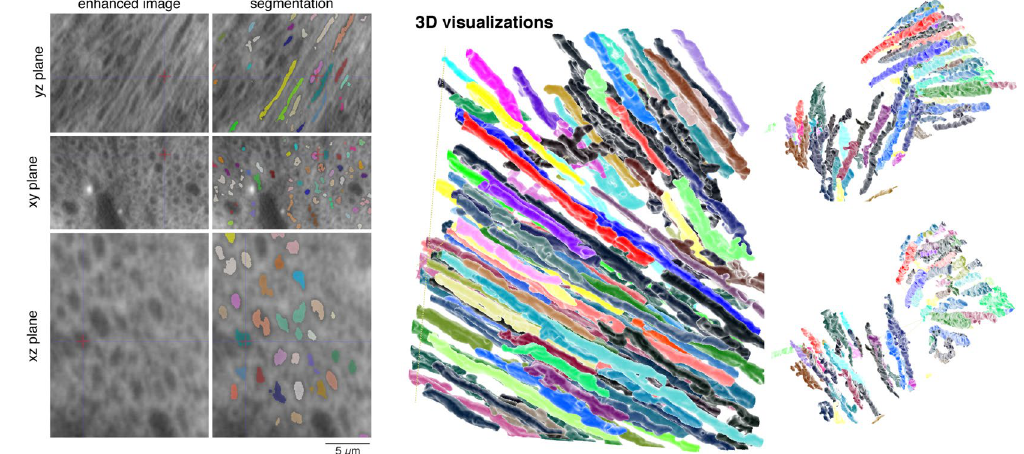
Figure 8. CNN-based enhancement enables automated segmentation of myelinated axons in mouse somatosensory cortex